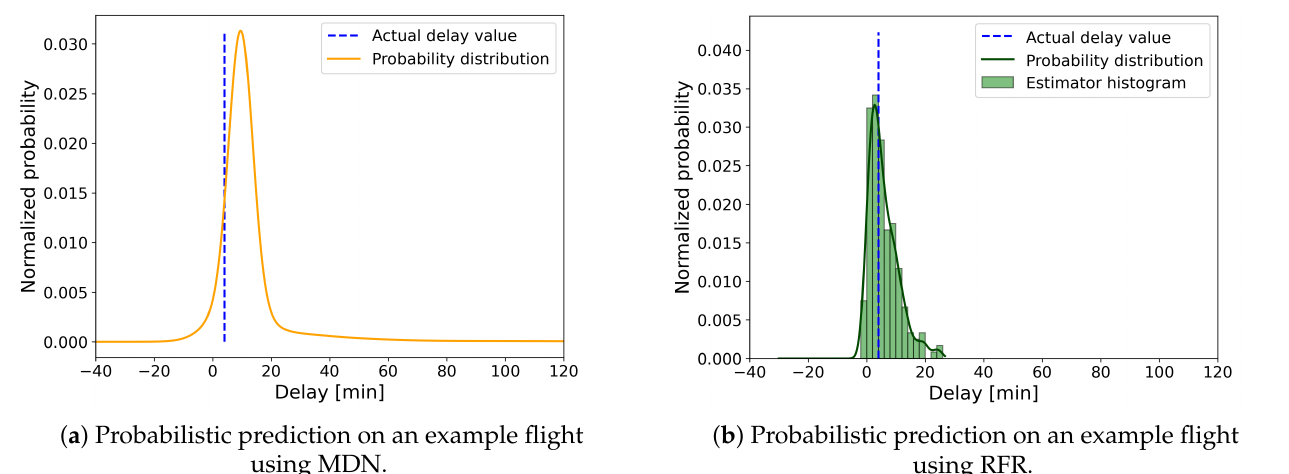
( a ) Probabilistic prediction on an example flight ( b ) Probabilistic prediction on an example flight using MDN. using RFR. Figure 4. An example of probabilistic prediction curves obtained from MDN and RFR for departure flight samples. Blue vertical lines indicate actual sample delay, orange curves depict the probability distribution obtained using MDN, green bars the histogram of RFR estimators, and green curves the probability distribution obtained from this histogram by KDE.